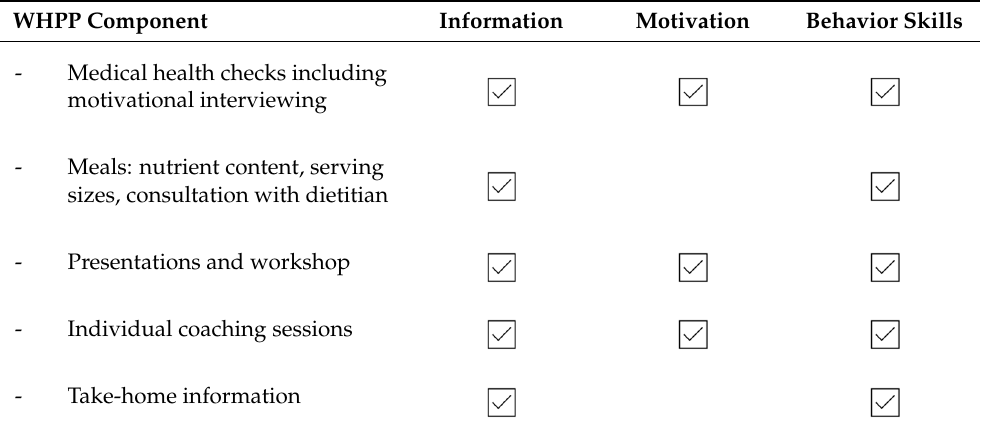
Table 2. Components of the WHPP with respect to the information–motivation–behavioral skills (IMB) model by Fisher et al. [48].